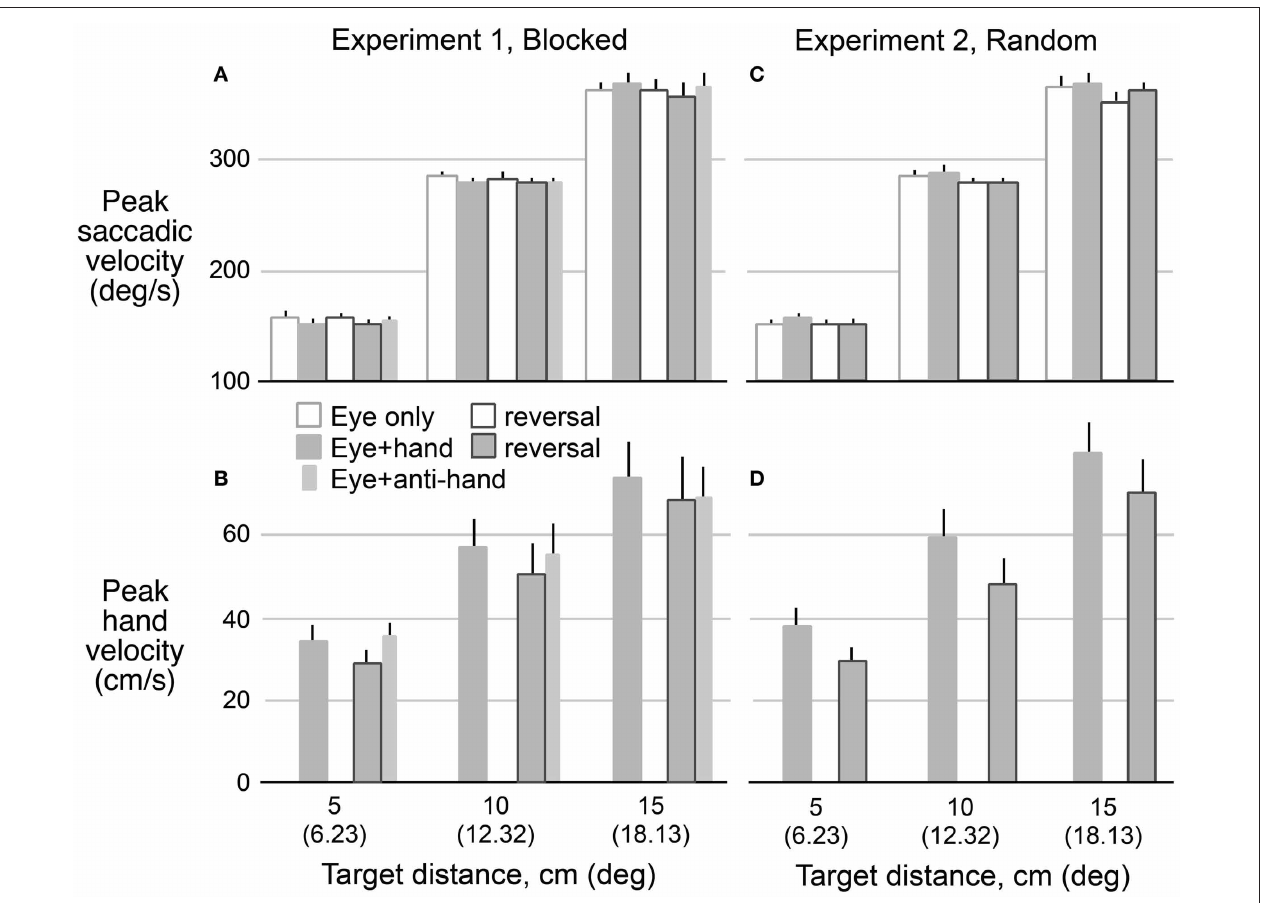
FIGURE 5 | Mean predicted velocity as a function of target amplitude for eye movements in Experiment 1 (A) and Experiment 2 (C) when eyes moved without hand movements (hollow bars) and with hand movements (filled bars) before and after the